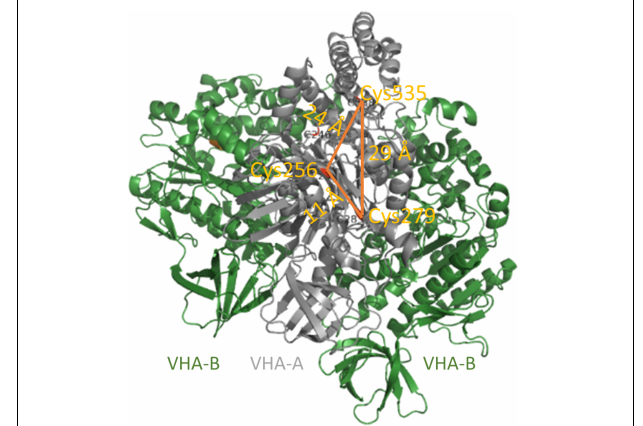
FIGURE 5 | Conserved cysteine of VHA-A. VHA-A bears three conserved cysteines. Their distances of 11–29 Å exceed the maximum distance for disulfide formation. Cys256 is located in the catalytic ATP-binding P-loop, and its redox modulation efficiently inhibits V-ATPase activity. The structure is based on pdb 3j9t (Zhao et al.,